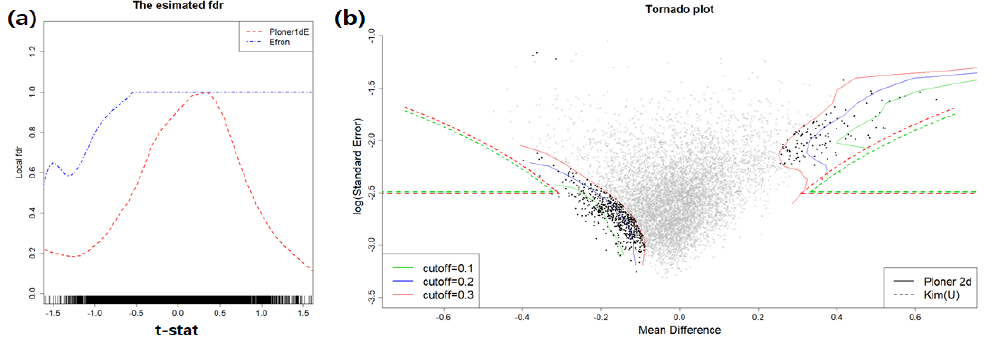
Figure 14. Lymphoma data. ( a ): estimated fdr1d; ( b ): estimated fdr2d. The fdr2d estimates for union null are provided in the right panel of Figure 14. Each gene is represented as dot in the figure. Here we consider different set of cutoff values (0.1, 0.2, 0.3). The reason is that unlike the Omija data, the number of genes rejected by all methods except for Kim(Intersection null) are almost 0. Three different cutoff values of target FDR are displayed in different colors: green (0.1), blue (0.2), and red (0.3). As seen in Table 8, there are small number of rejections by Kim (union null). The green line is exactly overlaid on the blue line and blue line is not shown in Figure 14. In contrast to the tornado plots from Omija data, there is not much overlap between two tornado plots from lymphoma data. From this, we can imagine that the results in practice heavily depend on the nature of the data. The following table includes the number of